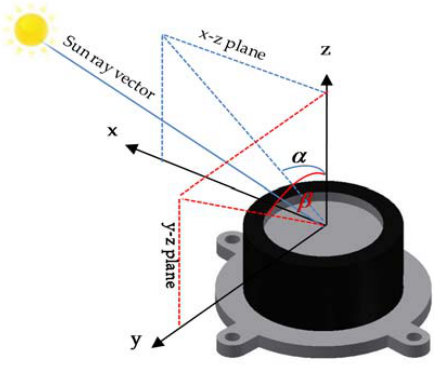
Figure 3. CAD diagram of a PSD type Sun sensor’s (ISS ‐ D60) reference frame and output angles.